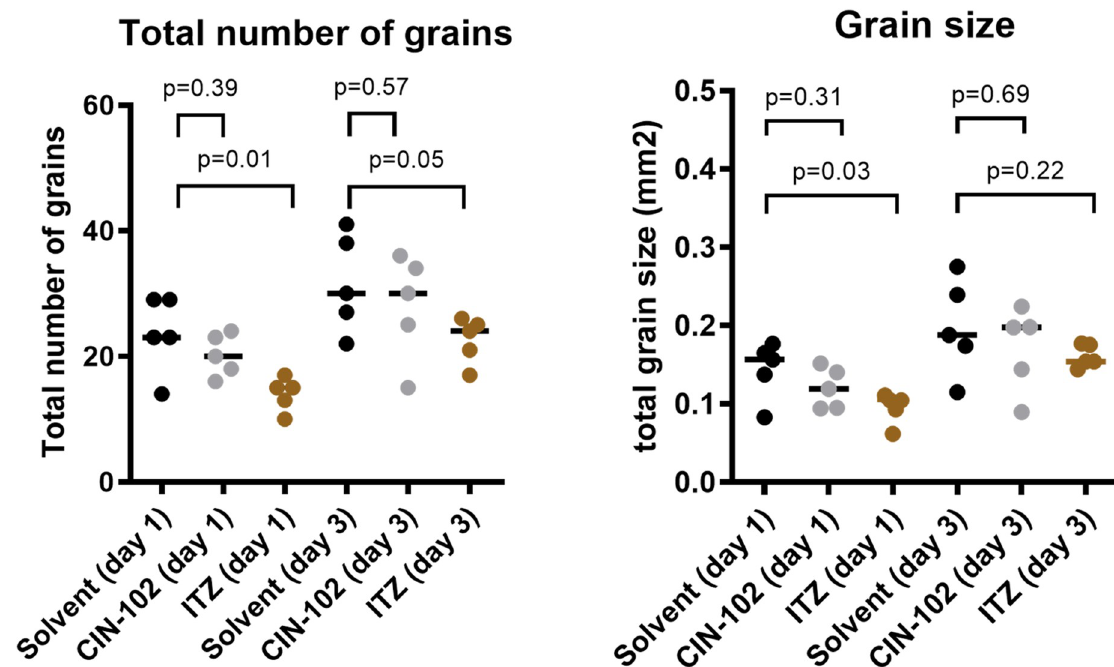
Fig 3. The total number and size of grains in M . mycetomatis infected G . mellonella larvae treated with solvent (black dots), 80 mg/kg CIN- 102 (grey dots), or 5.71mg/kg itraconazole (brown dots). Total number of grains counted in CIN-102 treated larvae do not differ at both one- and three-days post-infection (Man-Whitney, p = 0.39 and p = 0.57 respectively). The same is found for total grain size, for which no difference is found between CIN-102 treated larvae and the control, both one- and three-days post-infection (Man-Whitney, p = 0.31 and p = 0.69 respectively). Total number of grains counted in itraconazole treated larvae differed both one- and three-days post-infection (Man- Whitney, p = 0.01 and p = 0.05 respectively). Similarly, the total grain size differed between itraconazole and the control in both one- and three-days post-infection (Man-Whitney, p = 0.03 and p = 0.22